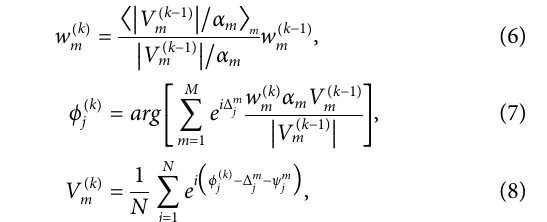
FIGURE 3 | The fl ow chart of the improved GSW algorithm for HOTA. ϕ j isupdatedineach loopandreachestheestimatedvalue ϕ ( k ) j after K iterations, generating the required